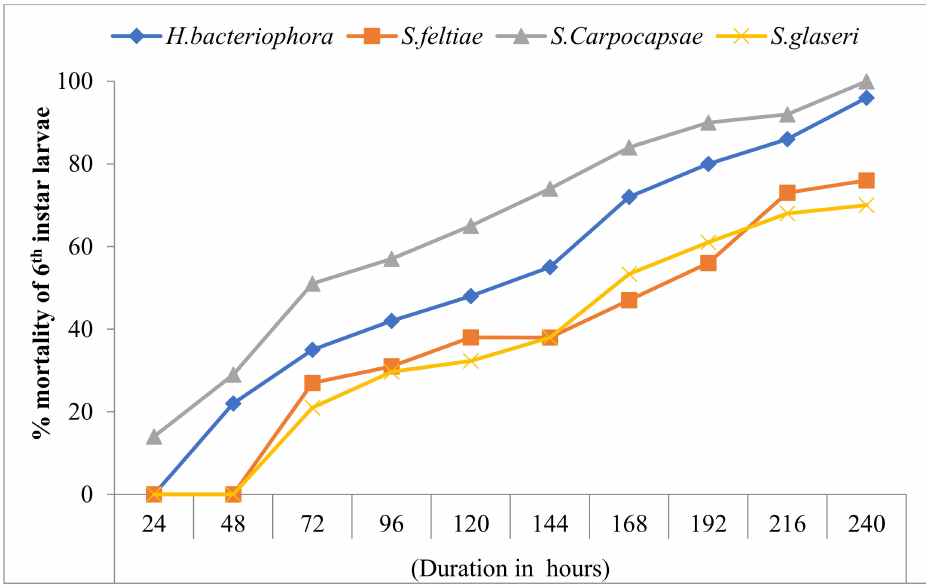
Figure 1. Cumulative mortality of 6th instar larvae of red palm weevil in hours following the application of four species of entomopathogenic